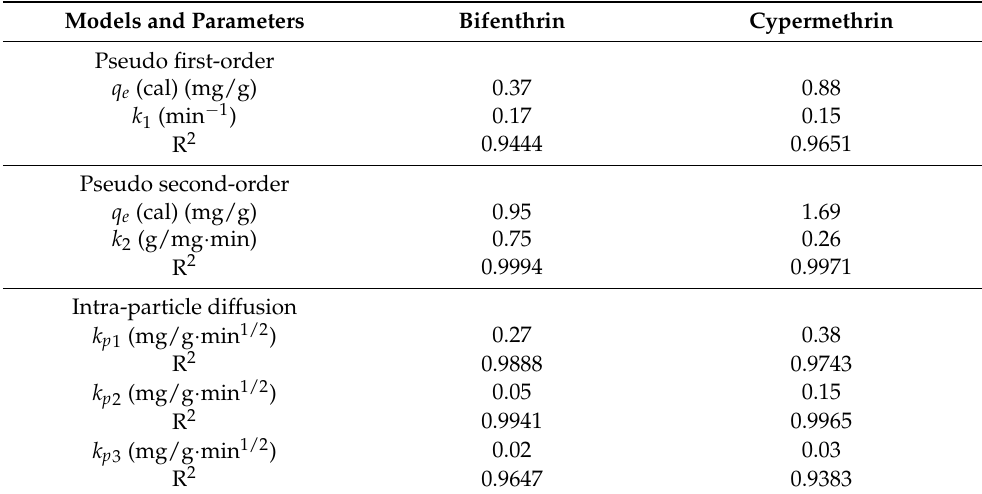
Figure 7. Pyrethroid adsorption capacity with ( a ) Pseudo first-order model, ( b ) Pseudo second-order model, and ( c ) Intra-particle diffusion model. Table 2. Adsorption kinetic model and the value of